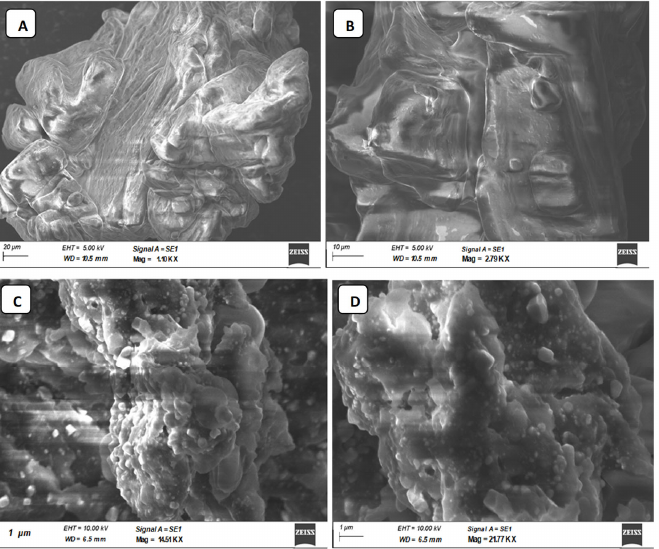
Figure 5. Photomicrographs of CIP3a and CMCIP3a recorded by SEM. ( A ) 1.10 KX × CIP3a, ( B ) 2.79 KX × CMCIP3a, ( C ) 14.51 KX × CMCIP3a, ( D ) 21.77KX ×